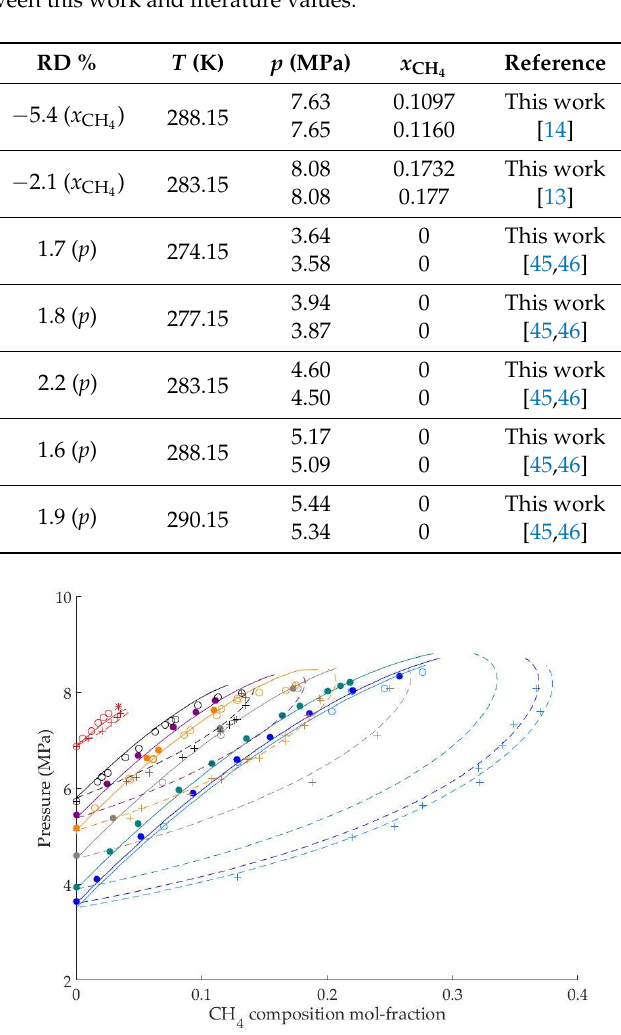
Figure 3. Liquid and vapor phase compositions of the CH 4 -CO 2 mixture between 273.15 and 301 K along eight isotherms: T = 273.15 K (cyan); T = 274.15 K (blue); T = 277.15 K (green); T = 283.15 K (grey); T = 288.15 K (288.5 K for Xu et al. [15] data) (orange); T = 290.15 K (purple); T = 293.4 K (black); T = 301 K (red). Experimental bubble points x CH4 from this work (filled dot), experimental bubble points x CH4 from other authors (empty dot), experimental dew points y CH4 from other authors (cross), critical point (star) [13–16]. Modelling of the bubble lines (solid-lines) and the dew lines (dotted-lines) is based on the SRK-EoS.